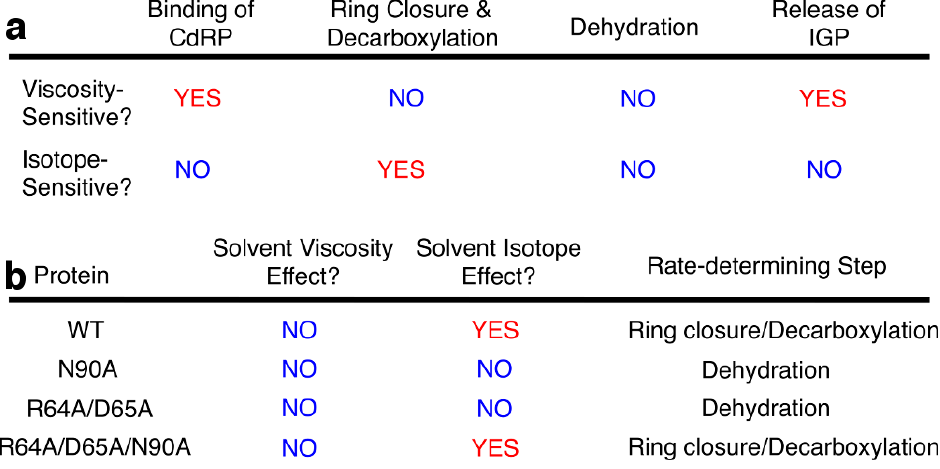
Figure 2. Perturbing interactions of the β 1 α 1 loop changes the identity of the rate ‐ determining step of ssIGPS catalysis. ( a ) Solvent viscosity and isotope effects provide insight into the identity of the rate ‐ determining step. Binding/release of substrate/product is dependent on solvent viscosity, but chemical steps are independent of solvent viscosity. Ring closure and decarboxylation are sensitive presence of D 2 O. ( b ) The presence of solvent viscosity and isotope effects for variant and WT ssIGPS and [29], respectively.